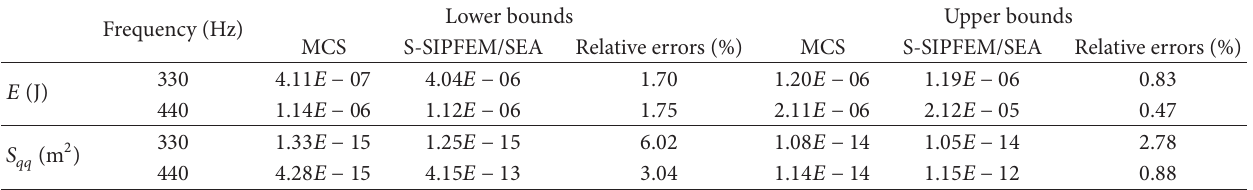
Table 8: The relative errors of the bounds of the plate energy and the autospectrum of the driving point displacements with three